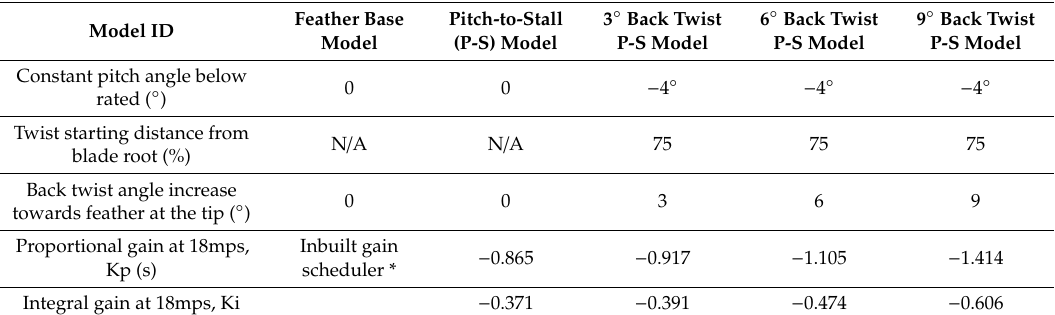
Table 1. Model parameters in terms of back twist, pitch below rated setting, and blade pitch controller controller gains.